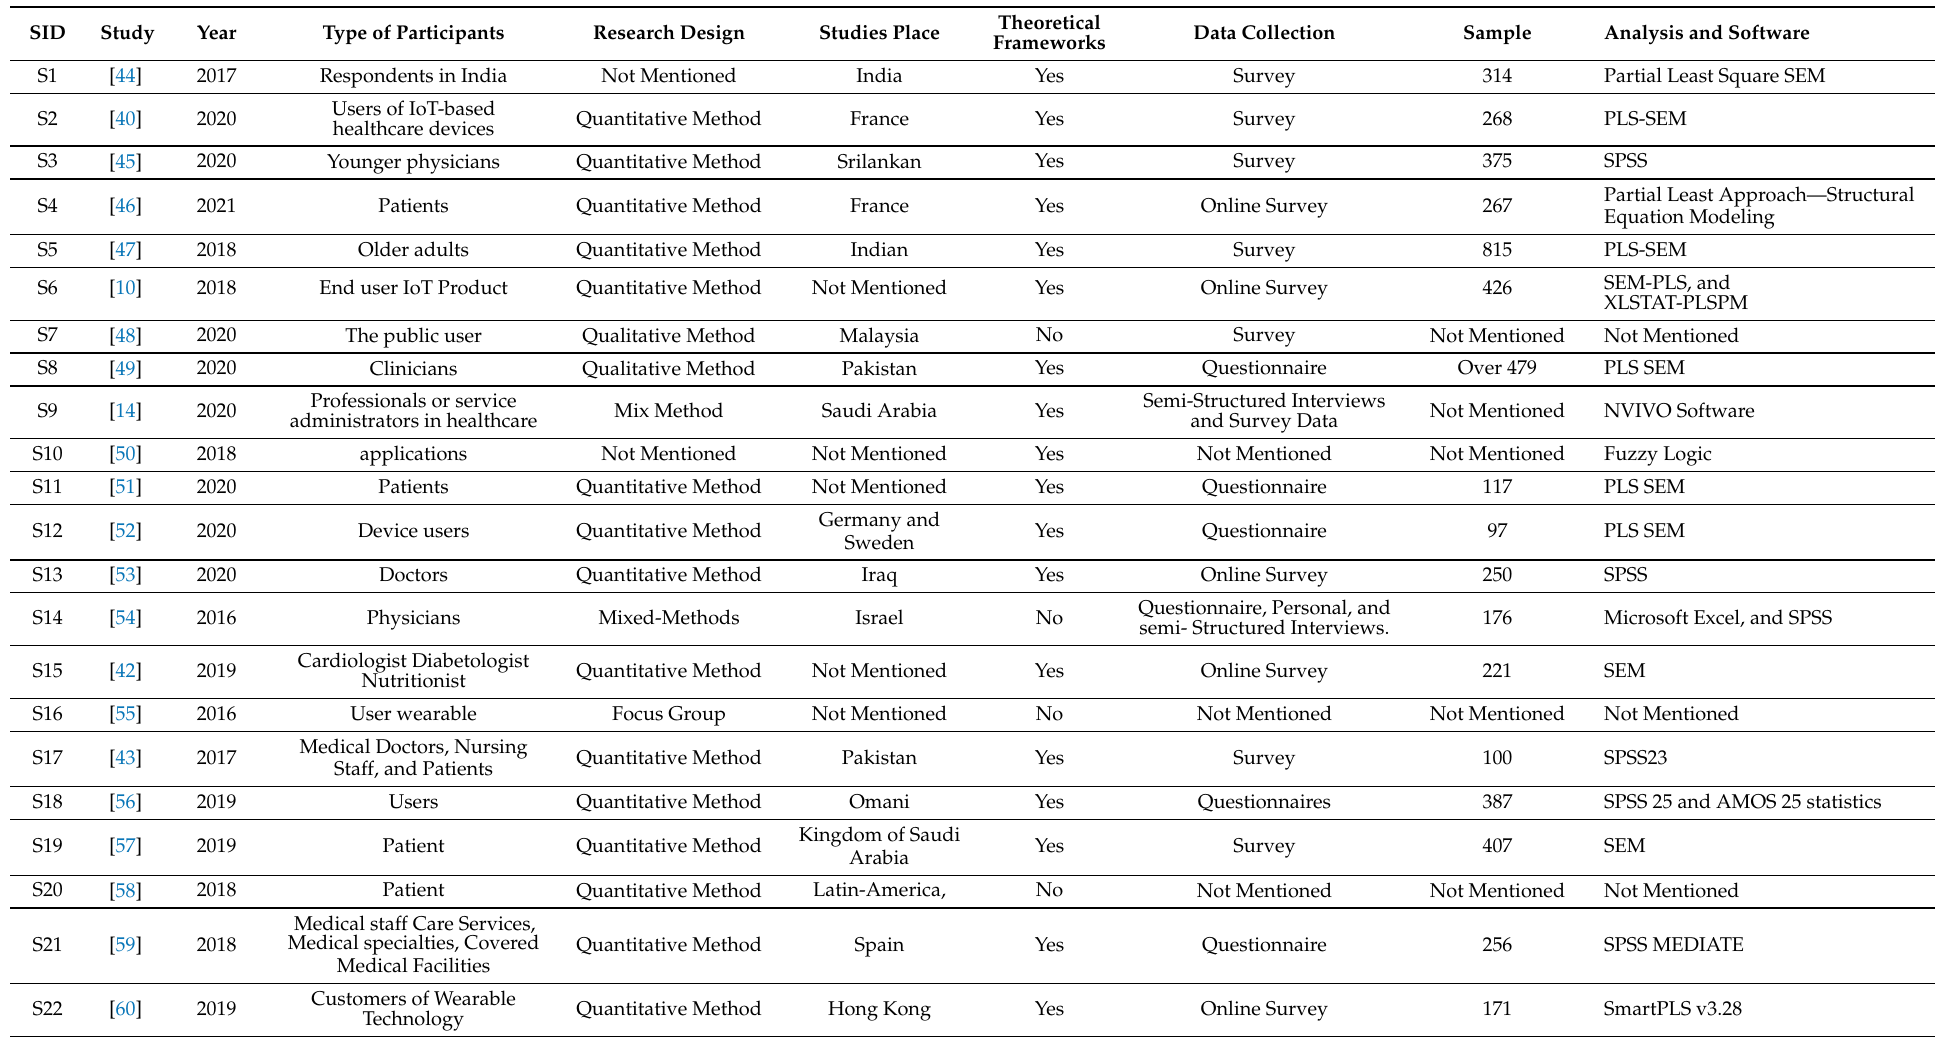
Table 4. Data extraction